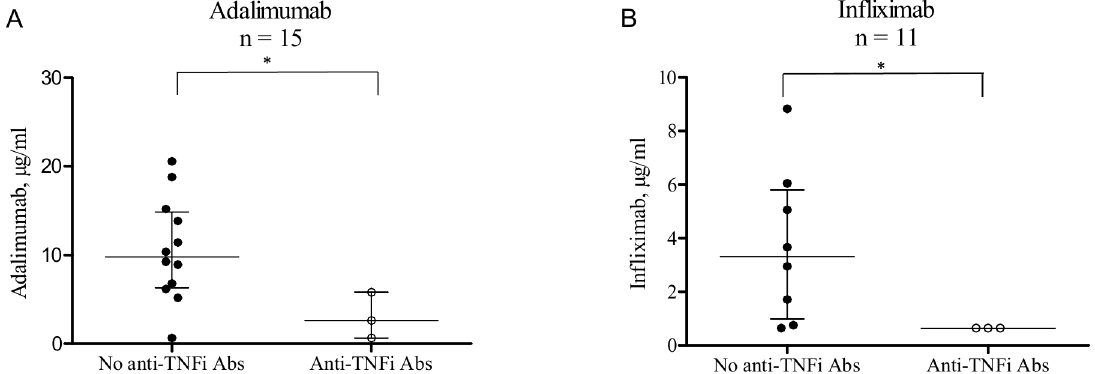
Fig 3. Serum TNFi levels in relation to antibodies against adalimumab and infliximab following six months of treatment. Antibodies towards the prescribed TNFi (anti-TNFi Abs) were measured in 26 patients with rheumatoid arthritis, using radioimmunoassay. Patients were treated with either adalimumab (A) or infliximab (B). Functional levels of TNFi were determined using reporter gene assays. Presence of anti-TNFi Abs correlated with lower levels of TNFi for both drugs * ( p < 0.05). Medians and interquartile ranges are